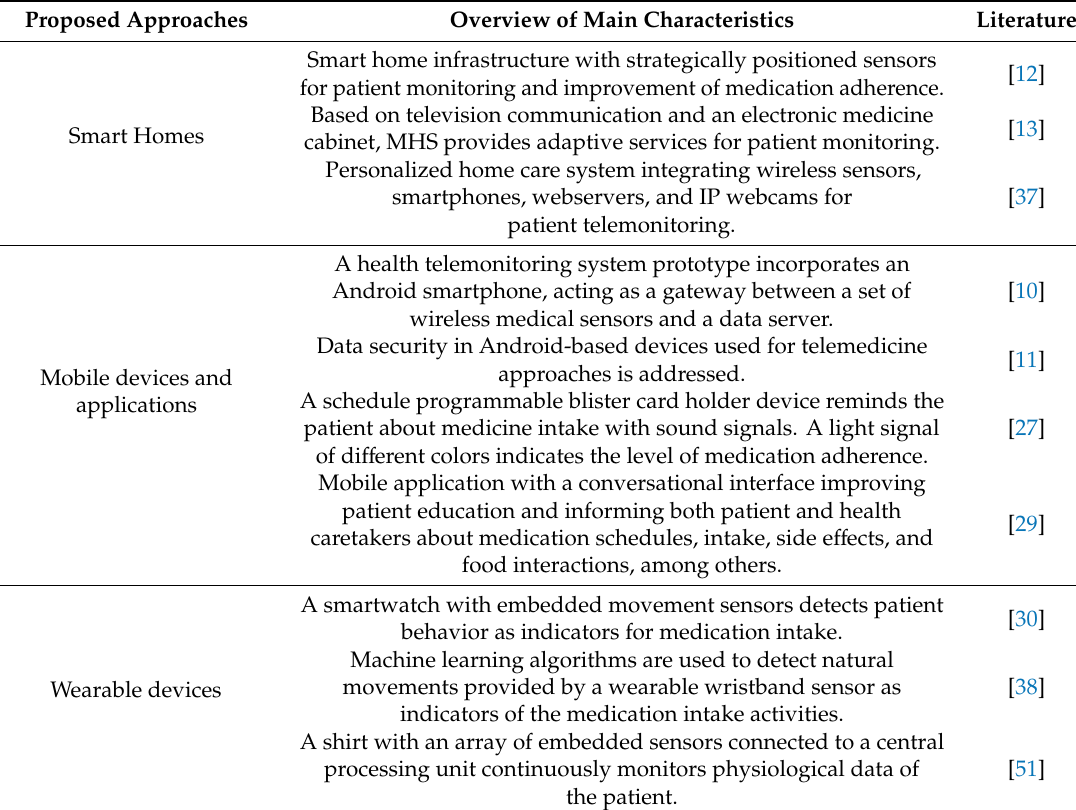
Table 1. Home health monitoring solutions.